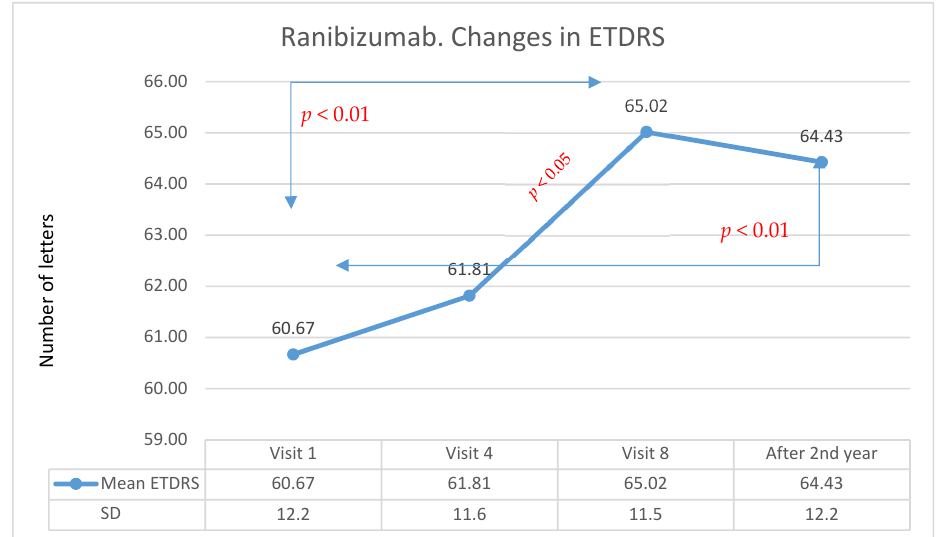
Figure 2. Changes in visual acuity in the ETDRS during individual follow-up visits for the Ranibizumab group. Red indicates statistically significant differences (Wilcoxon test).